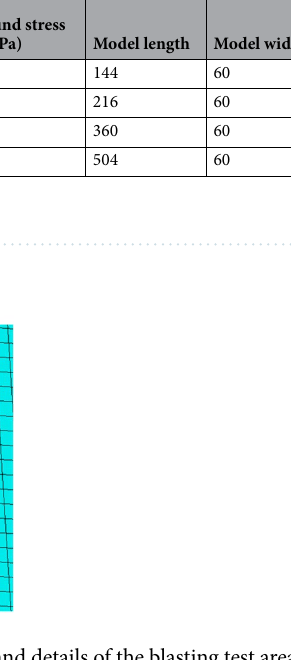
Figure 13. Section of the No. 2 numerical calculation model and details of the blasting test area.